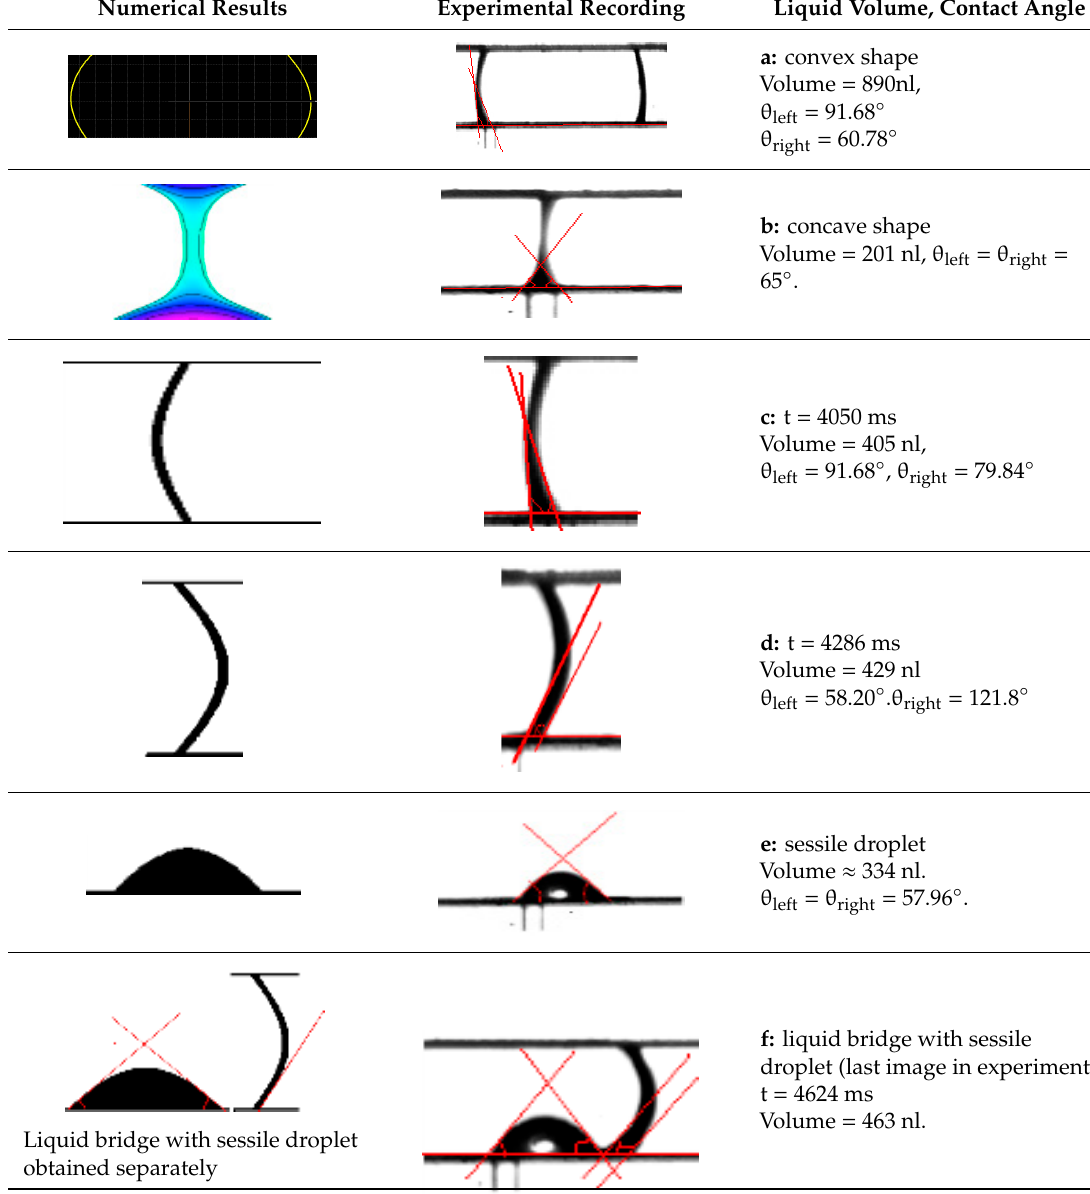
Table 3. Comparison of liquid bridge shapes obtained numerically and experimentally.